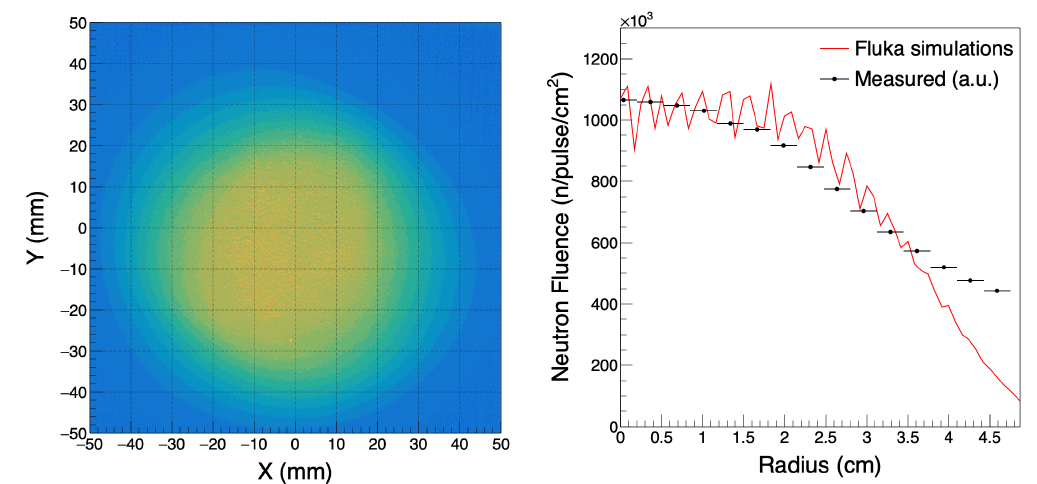
Figure 4. ( Left ) Beam profile in n_TOF EAR2 obtained with the big collimator as measured with the imaging device. ( Right ) Comparison between the measured and simulated radial beam profile for the measurement point at 220 cm from the experimental area